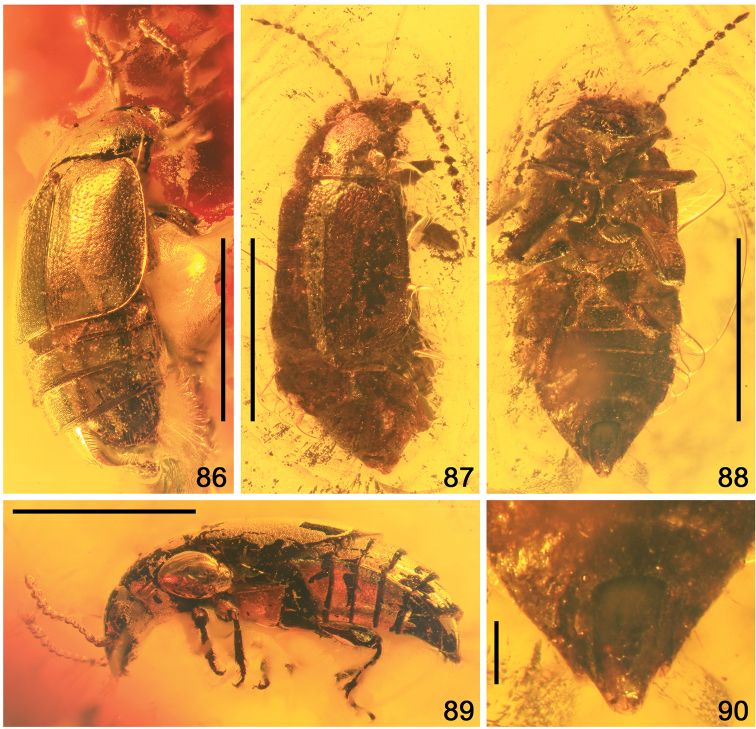
Eusphalerum spp. (86, 89Eu. sp. 3; 87, 88, 90Eu. sp. 4) 86 habitus, dorsolateral view 87 habitus, oblique dorsal view 88 habitus, ventral view 89 habitus, lateral view 90 abdominal apex, ventral view. Scale bars: 1.0 mm (86–89), 0.2 mm (90).